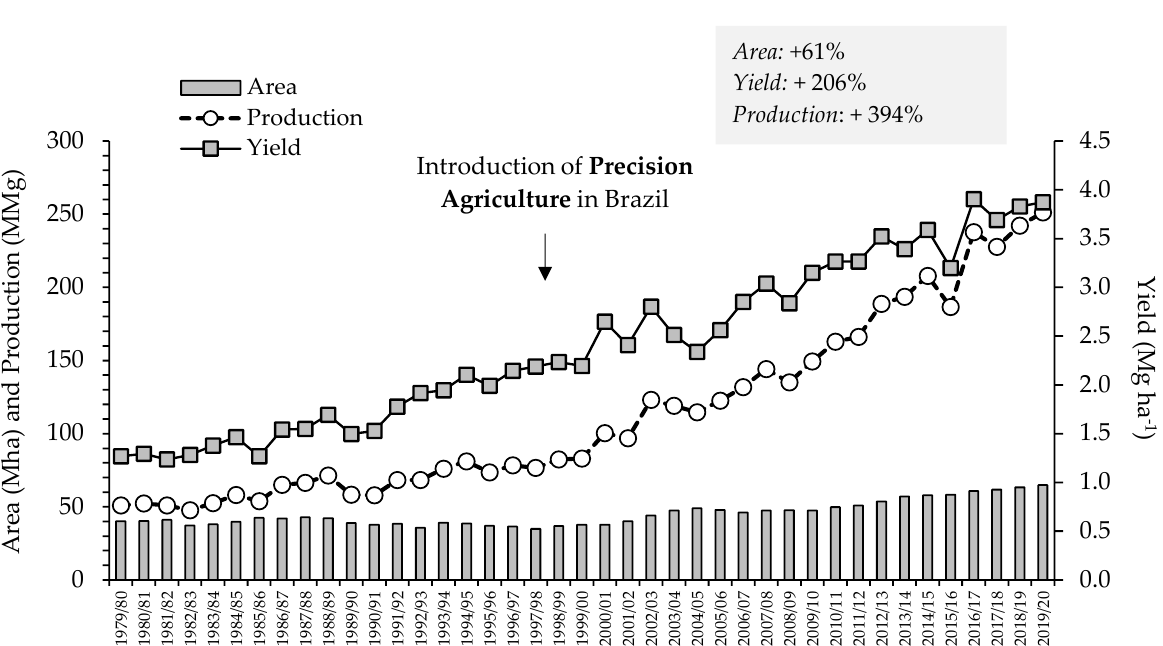
Figure 1. Evolution of cultivated area, production, and yield of grain in Brazil in the past four decades. This figure compares the evolution of the cultivated area in Brazil over the last 40 years with its total production and yield, showing the remarkable advances in crop yields (increased 206%) and grain production (increased 394%) within a cultivated area that has only expanded 61%. Adapted from CONAB [18].